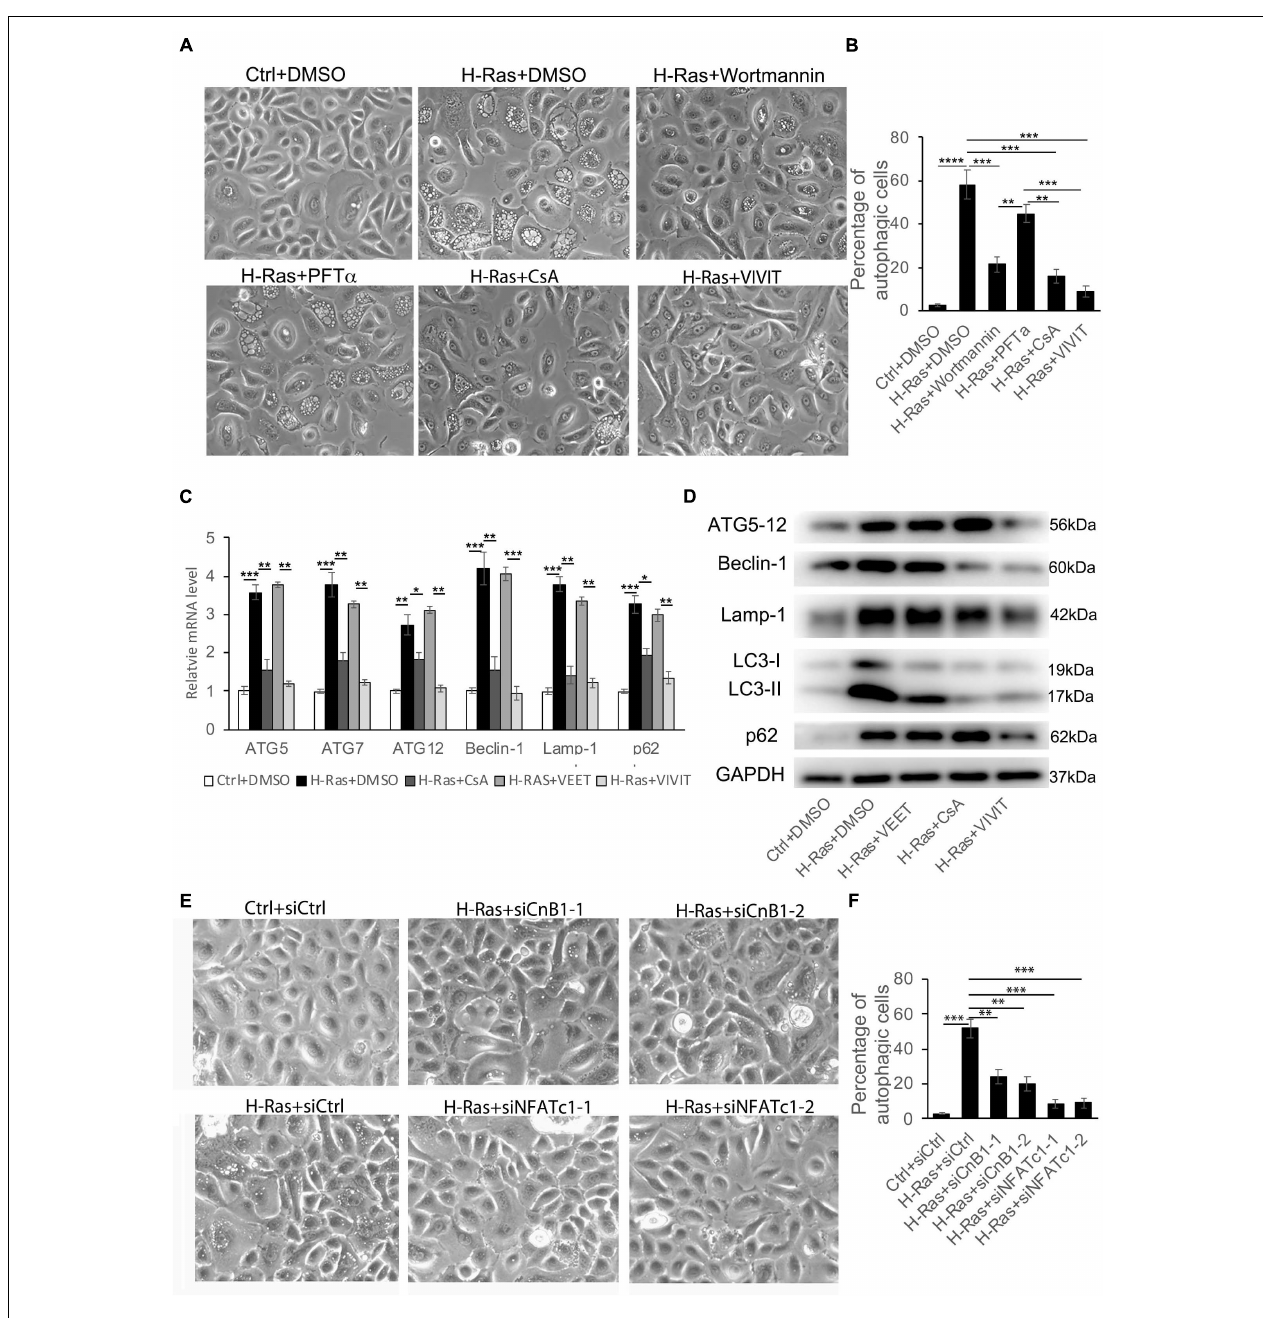
FIGURE 2 | H-Ras induced autophagy is suppressed by inhibition of the calcineurin/NFAT pathway. (A) Human keratinocytes infected with a H-Ras G 12 V expressing or a control retrovirus were treated with different inhibitors as indicated, DMSO as a negative control. Representative cell images 24 h after treatment are shown. (B) Quantification analysis of the percentage of cells with bubbles from panel (A). (C) Human keratinocytes infected with a H-Ras G 12 V expressing or a control retrovirus were treated with the calcineurin/NFAT inhibitors CsA or VIVIT, or with VEET as a control peptide for VIVIT for 24 h, then cells were collected for quantitative RT-PCR analysis of autophagy-associated genes as indicated. (D) Human keratinocytes were treated with the same conditions as shown in panel (C) , then were lysed for immunoblotting analysis of autophagy-associated genes as indicated, GAPDH as a loading control. (E) Human keratinocytes were transfected with two independent siRNAs of CnB1 (siCnB1-1 and siCnB1-2) or NFATc1 (siNFATc1-1 and siNFATc1-2) or scramble siRNAs (siCtrl) as a control, and 2 days later, the cells were infected with a H-Ras G 12 V expressing or a control retrovirus. Representative cell images 24 h after infection are shown. (F) Quantification analysis of the percentage of cells with bubbles from panel (E) . (B,C,F) All experiments were carried out three times, and error bars represent means ± SD; p values are indicated with “*,” * p < 0.05, ** p < 0.01, *** p < 0.005 when comparing two corresponding groups indicated with the black lines by Student’s t -test.